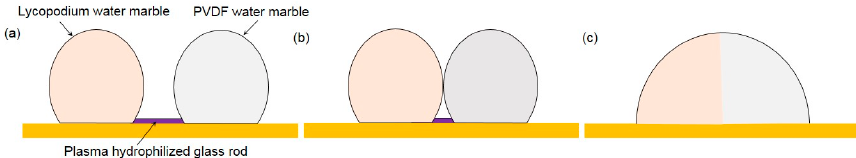
Figure 15. Schematic of forced coalescence of 30 μ L water marbles connected with the plasma hydrophilised glass rod. The orange marble is coated with lycopodium, the silver marble is coated with polyvinylidene fluoride (PVDF). ( a ) Marbles are connected with a glass rod (depicted in purple); ( b ) water wets the rod and marbles approach one another; ( c ) the final state of the coalescence.